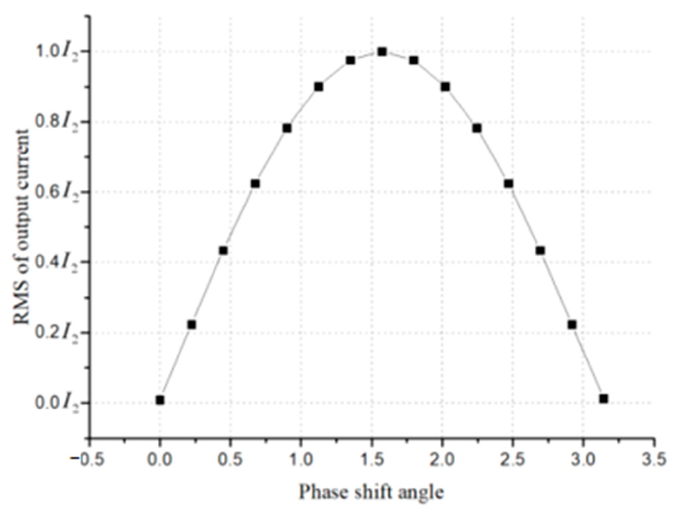
Figure 18. Output current—phase shift angle.